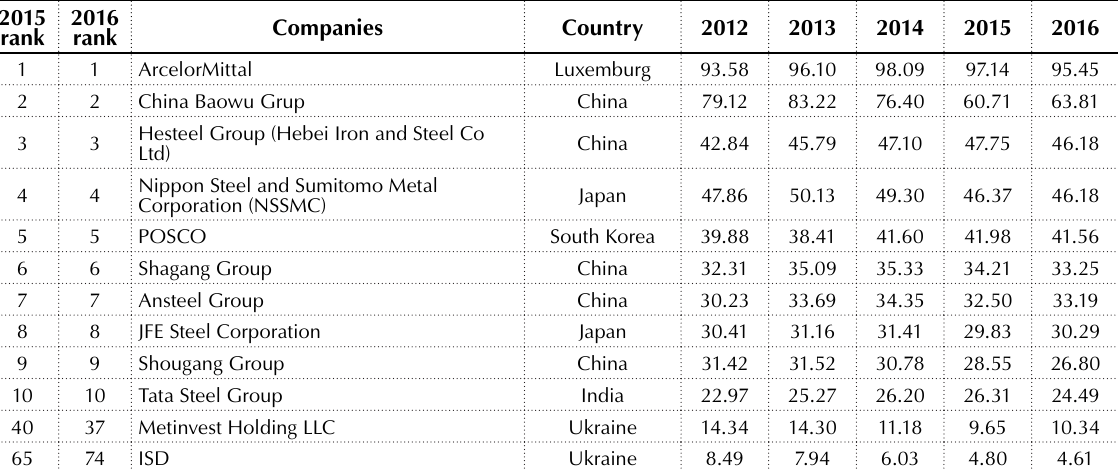
Table 2. Dynamics of steel production by the world corporations Source: The World Steel Association. Retrieved from https://www.worldsteel.org/